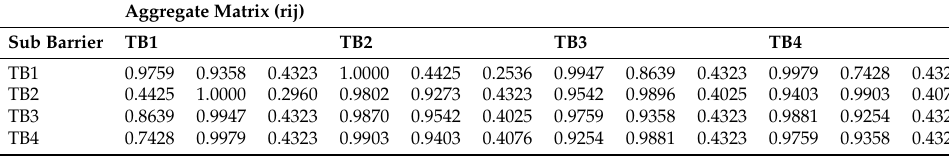
Table A5. The aggregated IF judgment